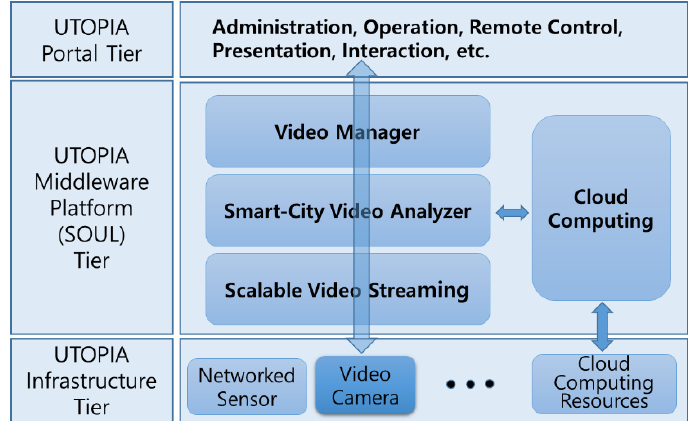
Figure 1. UTOPIA Smart Video Surveillance (USVS).